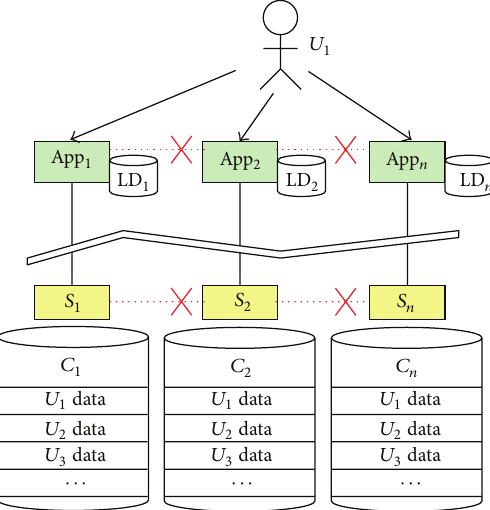
Figure 2: PDC: User-centric personal data